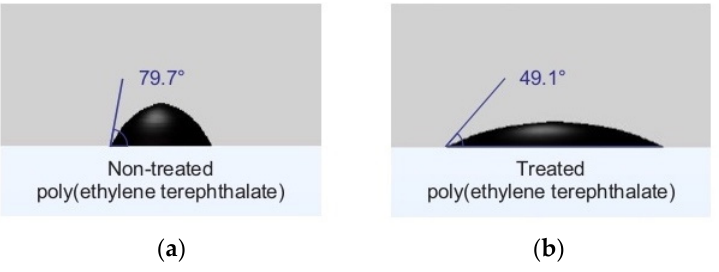
Figure 6. Droplet shape on non-treated ( a ) and treated ( b ) poly (ethylene terephthalate) surfaces.